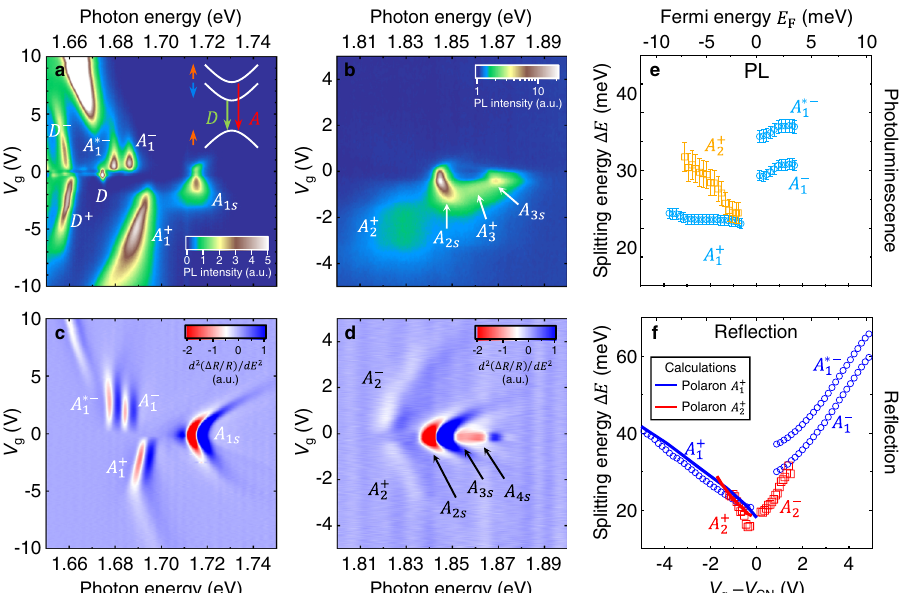
Fig. 5 Optical signatures of exciton-polaron Rydberg states in monolayer WSe 2 . a , b Gate-dependent PL maps plotted in arbitrary unit (a.u.). The inset in a shows the band con fi gurations in monolayer WSe 2 . The arrow beside each band denotes its electron spin. The red and green arrows between the bands denote the recombination transitions for bright exciton ( A ) and dark exciton ( D ), respectively. c , d Gate-dependent maps of the second energy derivative of the re fl ectance contrast d 2 ( Δ R / R )/d E 2 plotted in arbitrary unit (a.u.). e Gate-dependent PL energy separation between A þ and A 2s (orange squares) in a , b . The error bars (not shown if smaller than the symbols) represent the uncertainty in fi tting the PL spectra and between A þ 2 with multiple Lorentzian functions. f Gate-dependent energy separation between A þ in the d 2 ( Δ R / R )/d E 2 maps in c , d . We subtract the charge-neutrality gate voltage V CN (cid:3) − 0.14 V from the applied gate voltage V g . The blue (red) solid line is the calculated A þ ( A þ ) binding energy by our theoretical model of exciton polarons. The measurements were made at temperature T (cid:3) 15 K with no 1 2 magnetic fi eld. Table 2 Measured binding energies of exciton polarons for monolayer WSe 2 .